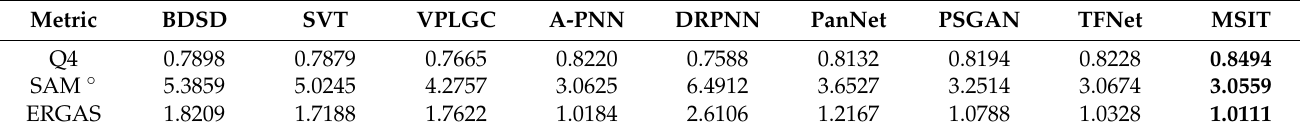
Table 2. Numerical evaluations of the fused images in Figure 5 (GeoEye-1